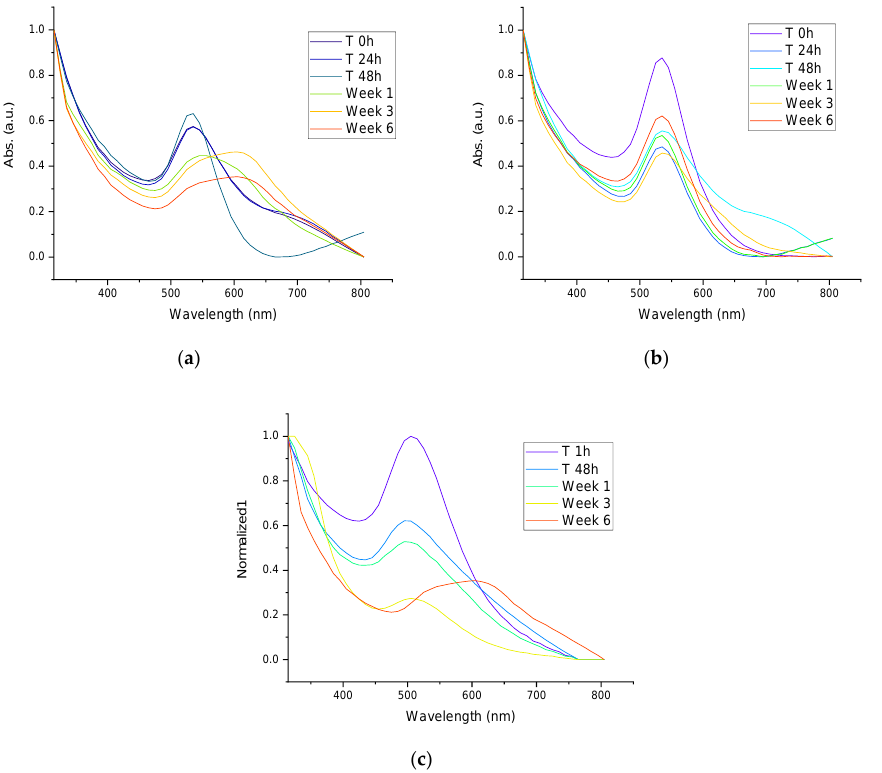
Figure 5. ( a ) UV-Vis spectra of stability of colloidal AuNPs synthesized with Mullein extract, ( b ) UV-Vis spectra of stability of AuNPs incorporated in silica particles by synthesis-1, ( c ) UV-Vis spectra of stability of AuNPs incorporated in silica particles by synthesis-2.